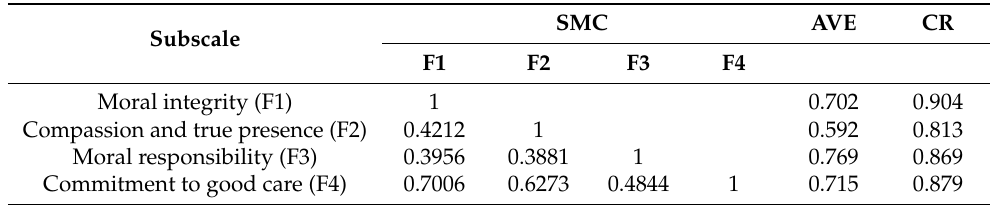
Table 3. Squared multiple correlation (SMC), average variance extracted (AVE), and composite reliability (CR) of the